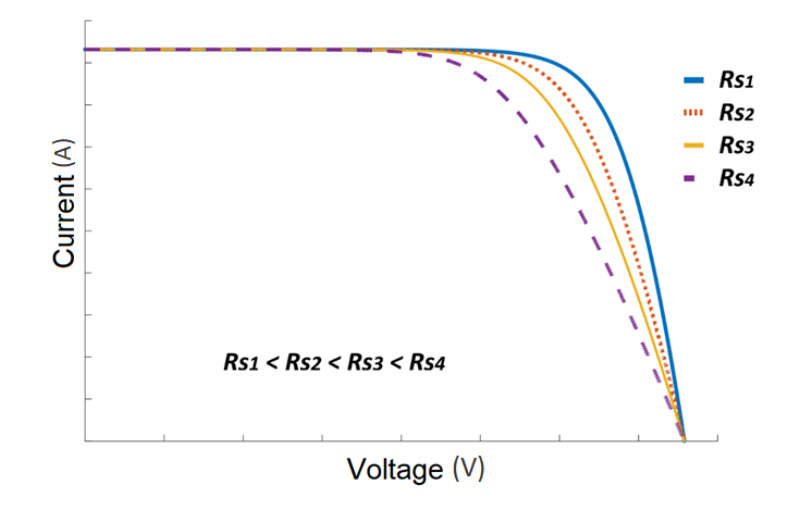
Figure 4. Effect of different series resistance ( R s ) on the I-V curve of the cell